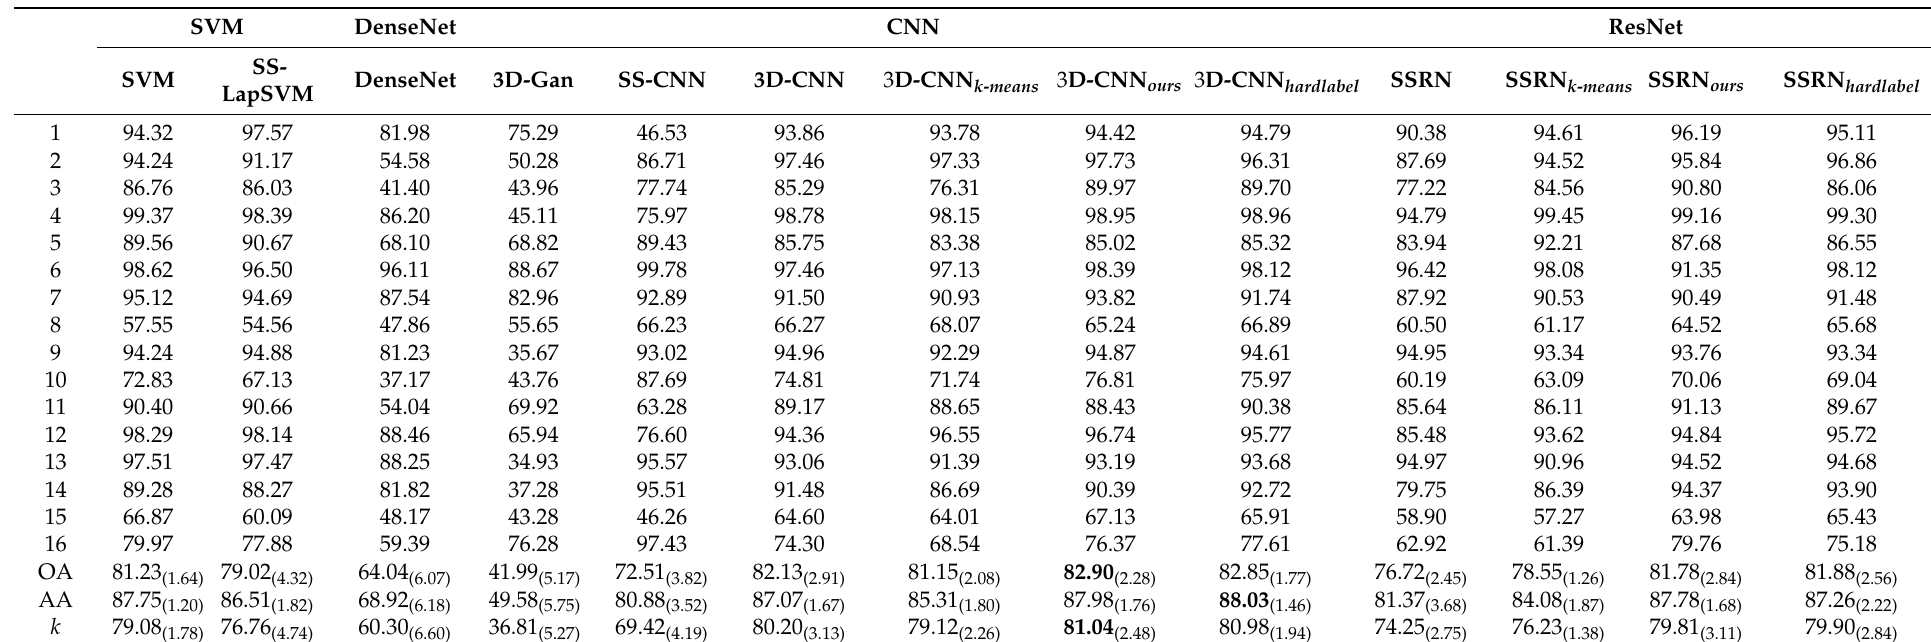
Table 5. Classification accuracy (%) for all methods with five training samples on the Salinas